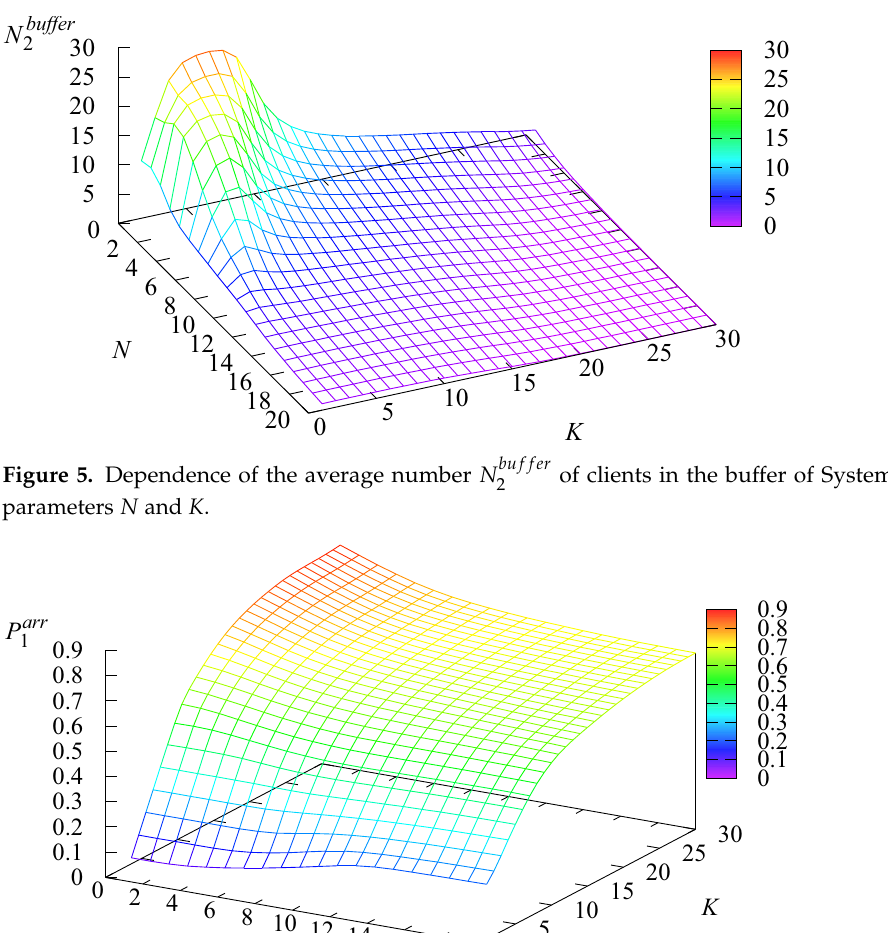
that an arbitrary client joins System 1 upon arrival on 1